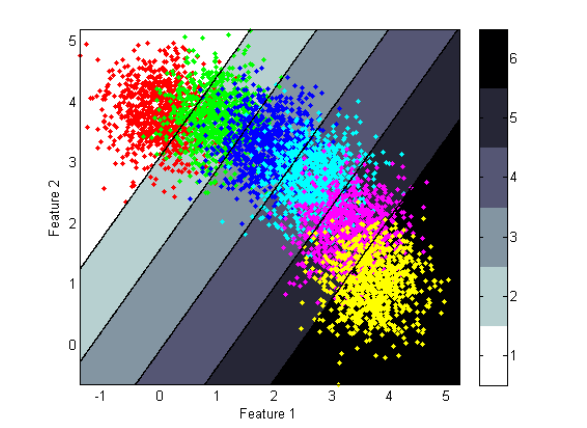
Figure 7: Support Vector Ordinal Regression is characterized by parallel discriminant functions resulting in a very compact